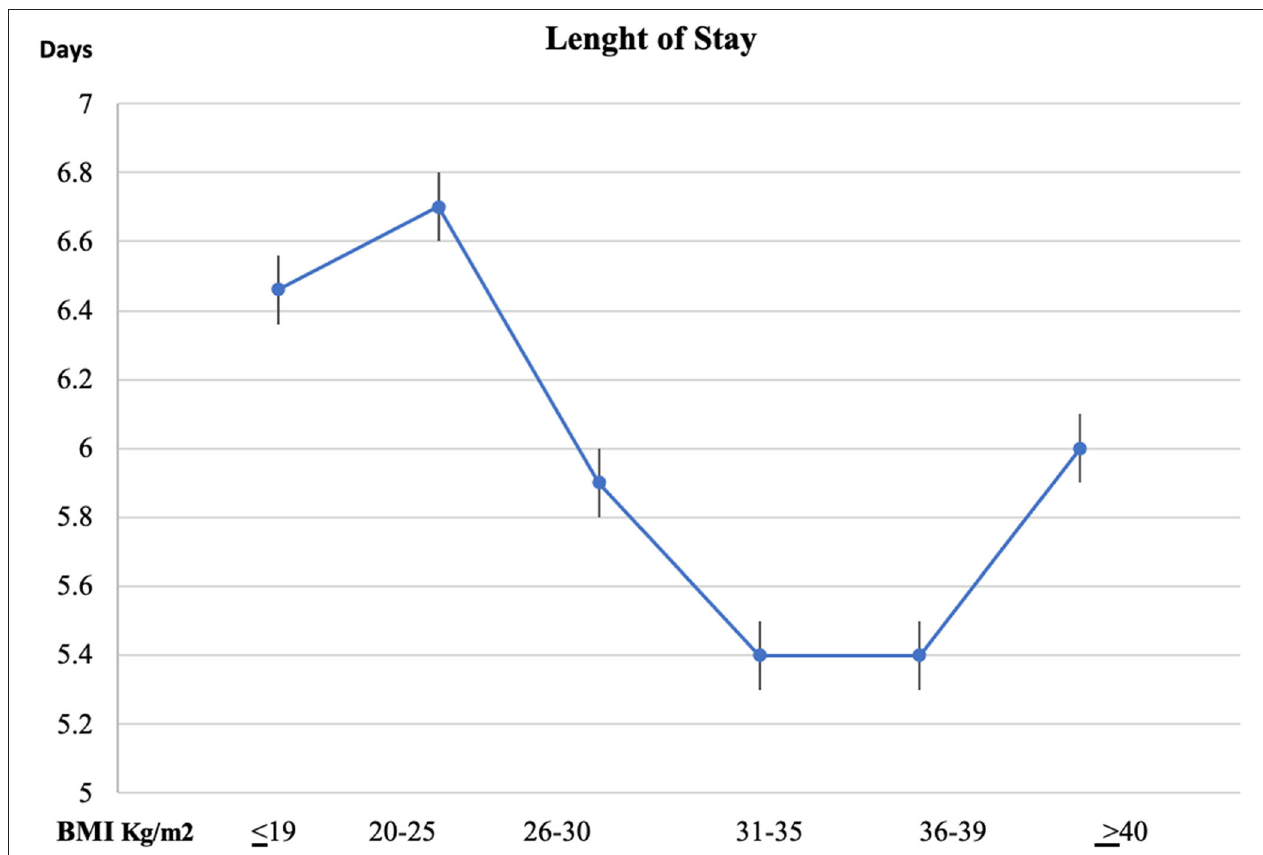
FIGURE 2 | Length of Stay via BMI